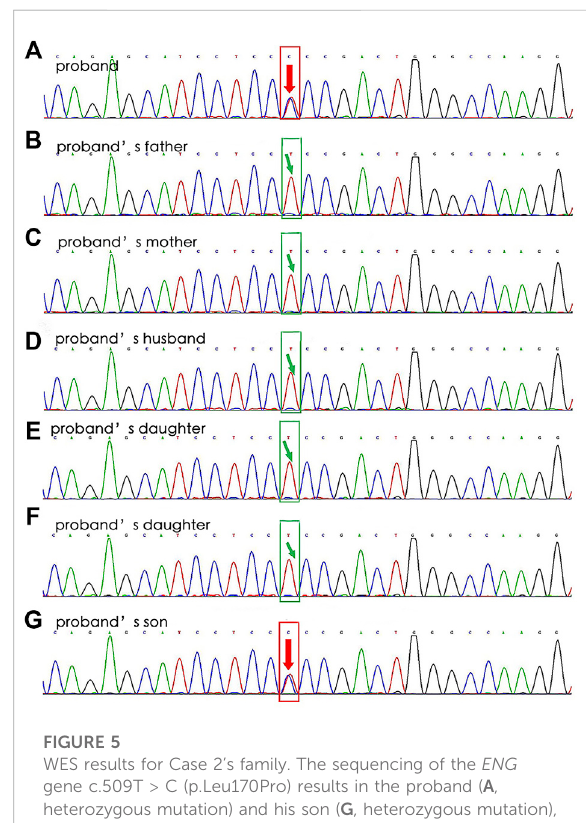
FIGURE 5 WES results for Case 2 ’ s family. The sequencing of the ENG gene c.509T > C (p.Leu170Pro) results in the proband ( A , heterozygous mutation) and his son ( G , heterozygous mutation), without in other relatives (B – F)